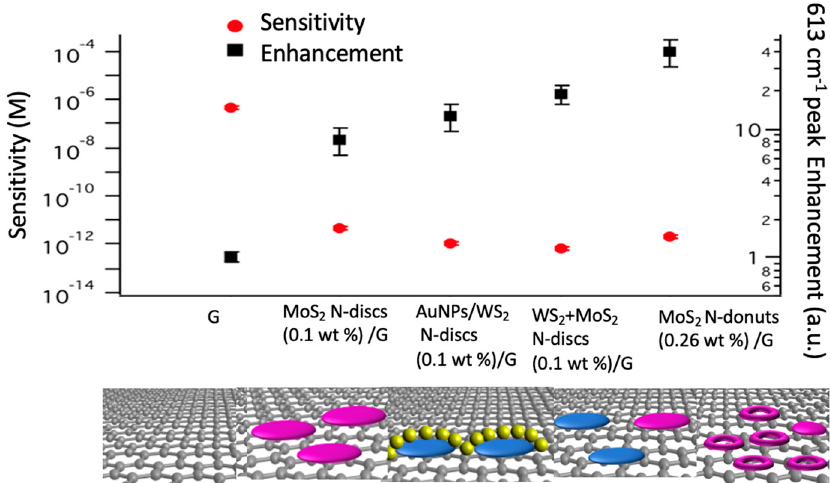
Figure 6. Comparison of SERS Sensitivity and R6G 613cm − 1 peak enhancement on different SERS substrates: graphene, MoS 2 N-discs (0.10 wt%)/graphene, AuNPs/MoS 2 N-discs (0.10 wt%)/graphene, WS 2 N-discs +MoS 2 N-discs (0.10 wt%)/graphene and MoS 2 N-donuts (0.26 wt%)/graphene. The R6G Raman peak intensities at 613 cm − 1 and 773 cm − 1 as a function of the R6G